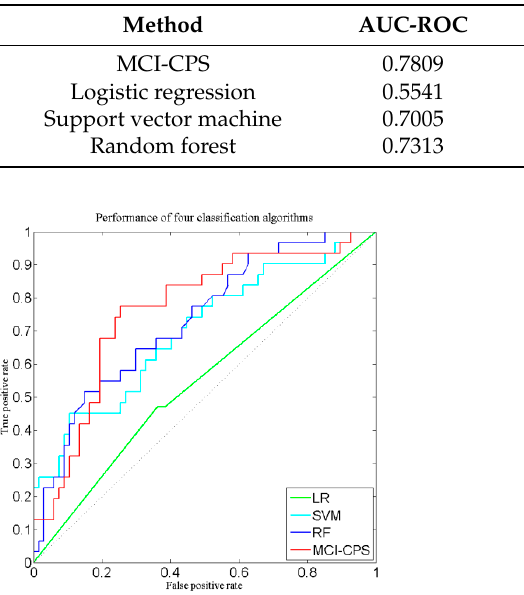
Table 3. Comparison of methods for predicting conversion from MCI to AD among four classification algorithms derived from ADNI-1.